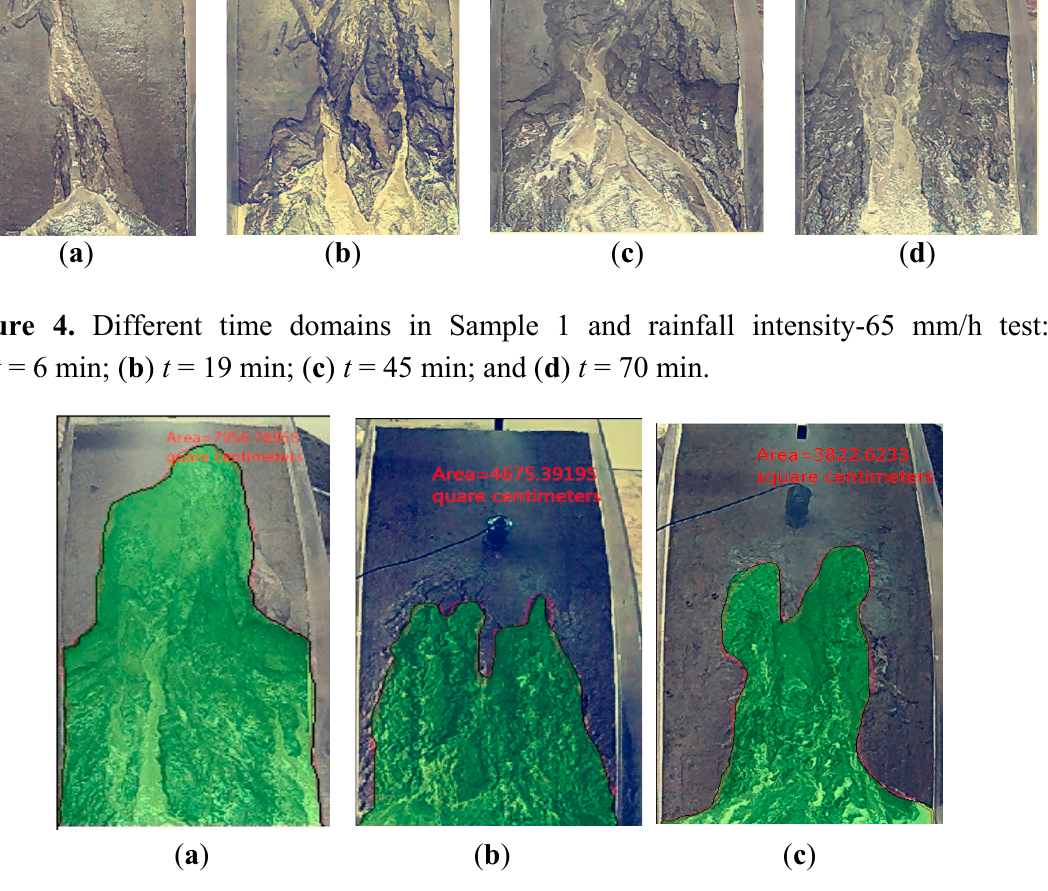
Figure 5. Different materials under the same time domain (45 mm/h; t = 52 min): ( a ) soil Sample 1 and erosion area-771.21 mm 2 ; ( b ) soil Sample 2 and erosion area-421.31 mm 2 ; ( c ) soil Sample 3 and erosion area-359.46 mm 2